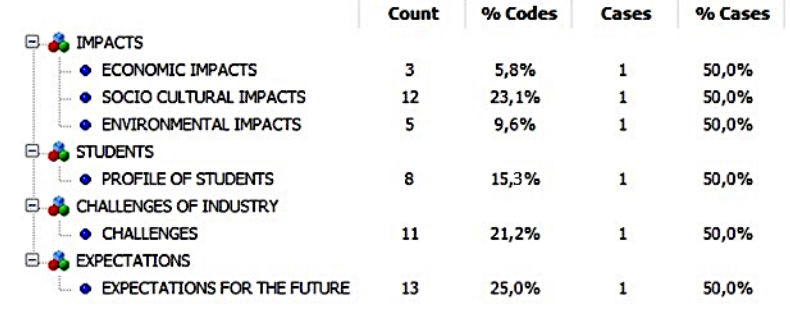
Figure 4: QDA Miner analysis of